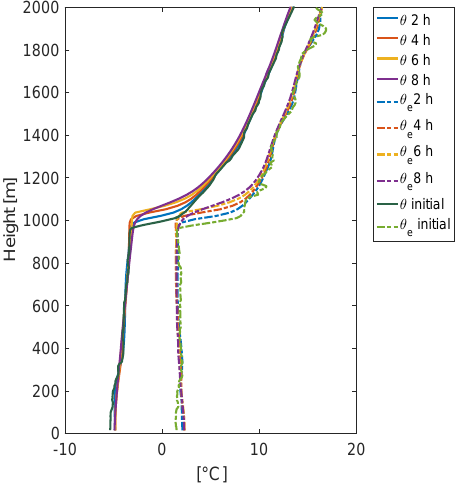
Figure 10. θ (left) and θ e (right) profiles of the initial condi- tions (dark green and green) and domain-averaged profiles after 2h (blue), 4h (orange), 6h (yellow), and 8h (purple) after the start of the SensMoist simulation with a RH of 10%.